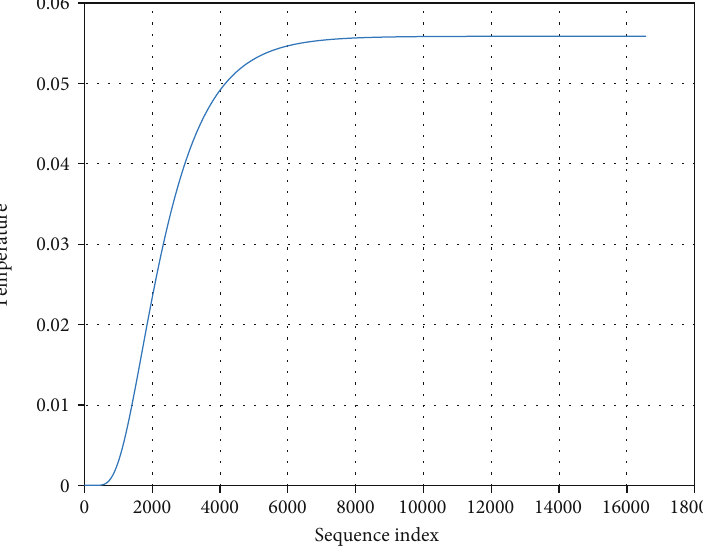
Figure 8: Sequence behavior at point